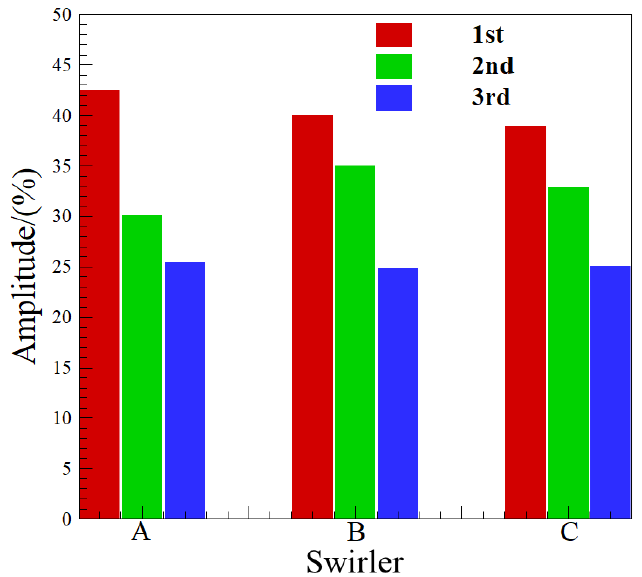
Figure 9. The first three order singular value energy proportions of different swirlers.